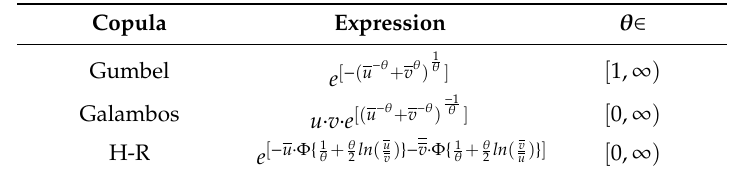
Table 1. Extreme value copula parameters.